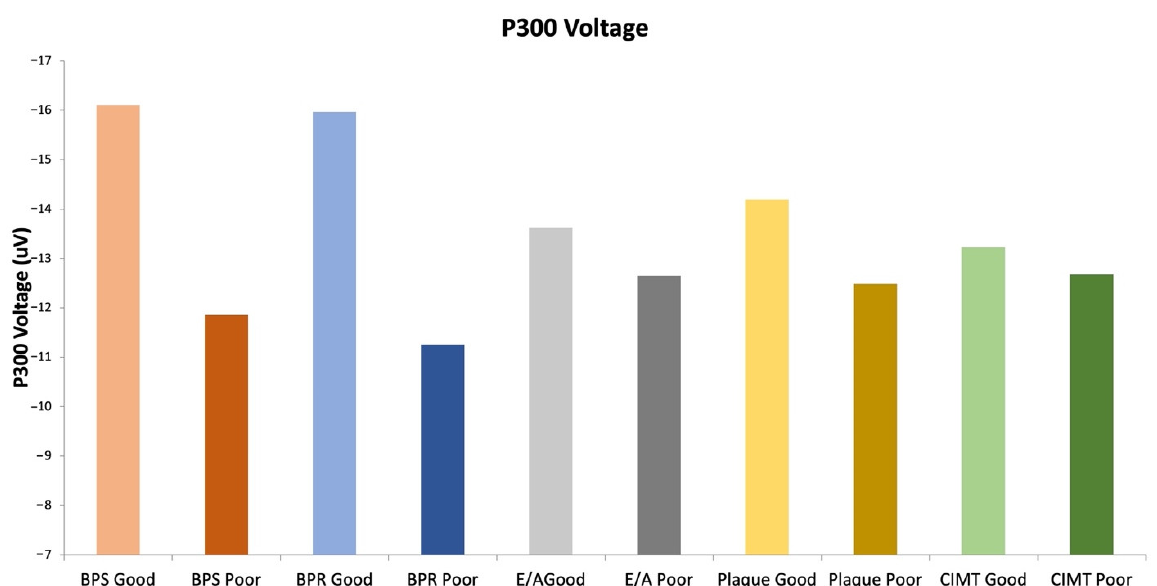
Figure 3. The average P300 latency for all tested heart biomarkers comparing Good versus Poor Levels. In all categories, Good Levels displayed faster latencies than for Poor Levels.